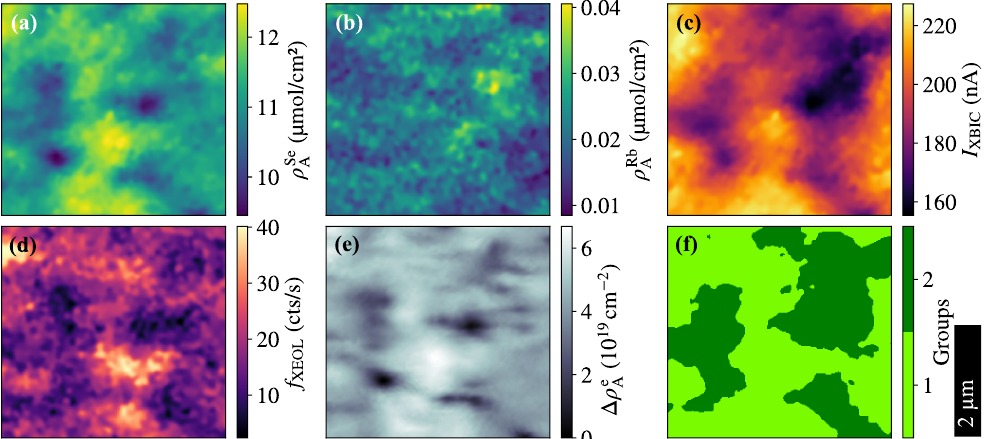
Figure 4. ( a , b ) Area density of Se ( ρ Se from electrical performance measurements. ( d ) Photon count rate ( f XEOL ) from XEOL measurements. ( e ) Relative area density of electrons ( ∆ ρ e from a k -means clustering of the maps shown in ( a – e ).